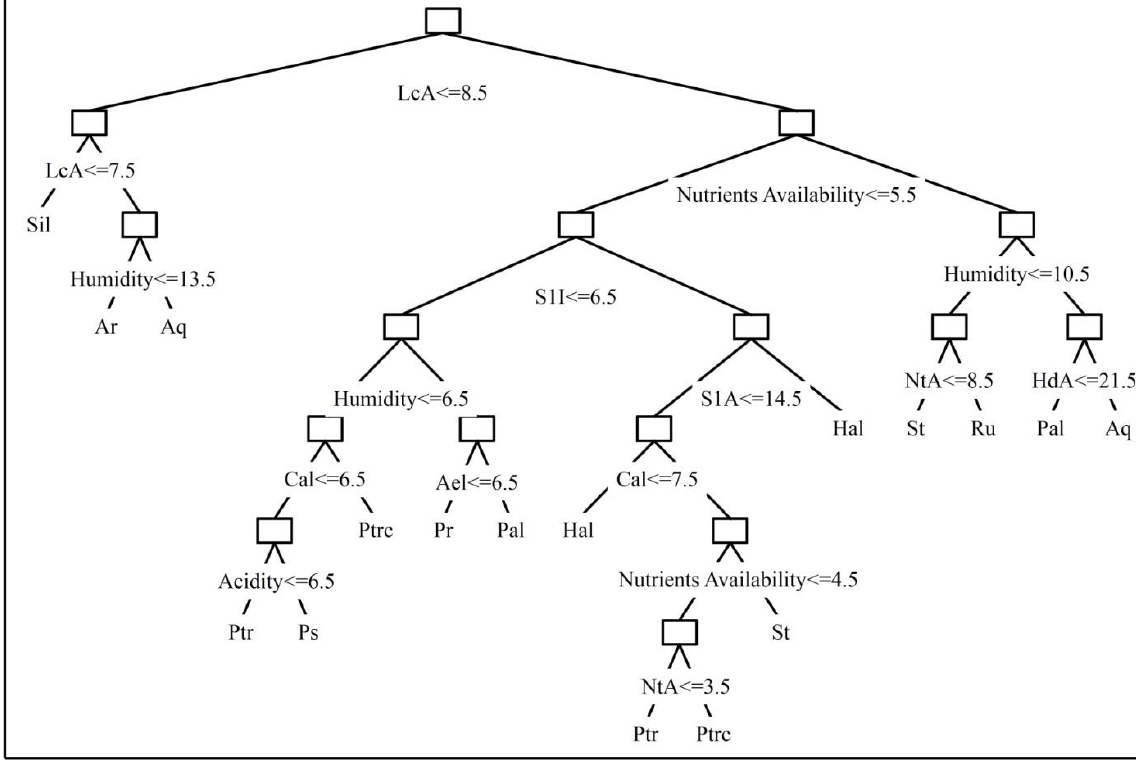
Рис. 3. Классификационное древо диагностики ценоморф растений на основе фитоиндикационных шкал. Условные обозначения: Ar – ариданты; Aq – акванты; Hal – галофанты; Pal – палюданты; Pr – пратанты; Ps – псаммофанты; Ptr – петранты; Ptrс – кальце-петранты; Ru – рудеранты; Sil – сильванты; St – степанты; Humidity – оптимальное значение режима влажности; Cal – нижняя граница карбонатности почв; LcA – верхняя граница режима освещения; Nutrients Availability – оптимальный режим трофности; S1I – нижняя и S1A – верхняя границы режима минерализации эдафотопа; HdA – верхняя граница режима увлажнения; Ael – нижняя граница режима аэрации; NtA – верхняя граница содержания азота в